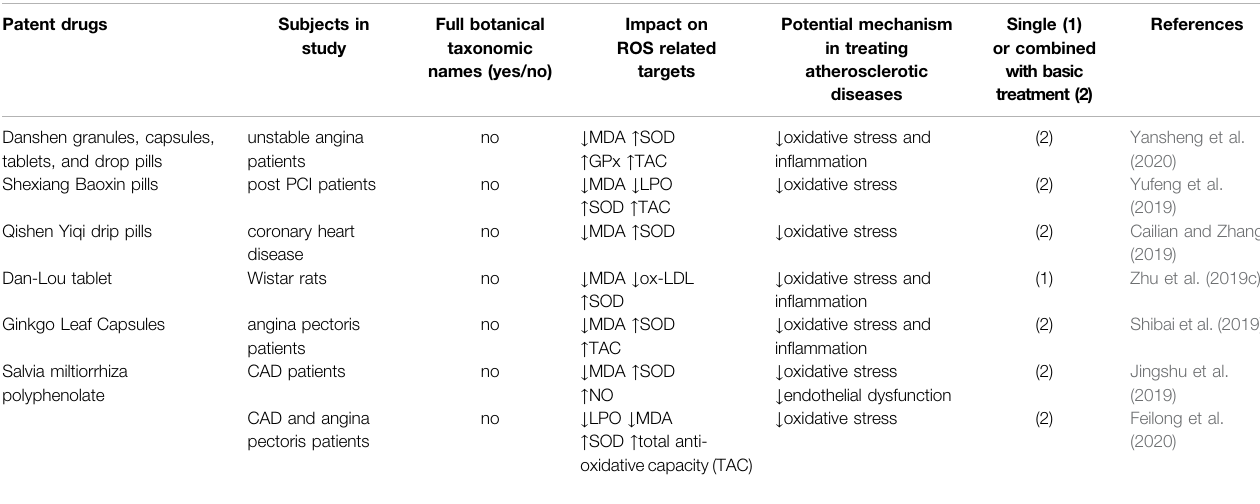
TABLE 9 | Patent drugs that treat atherosclerosis by regulating oxidative